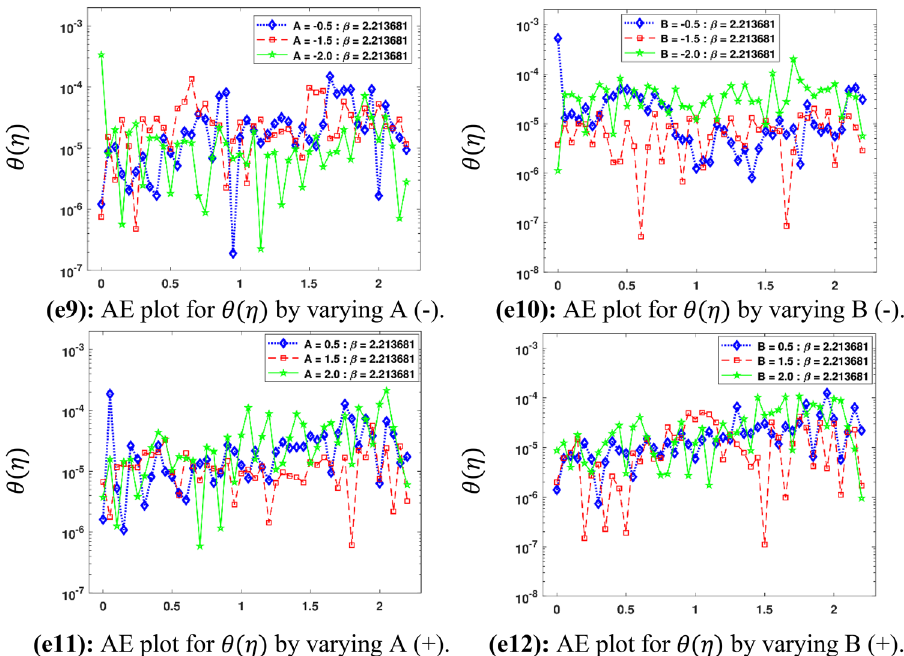
Figure 15. AE plots for outputs by proposed scheme and reference data.